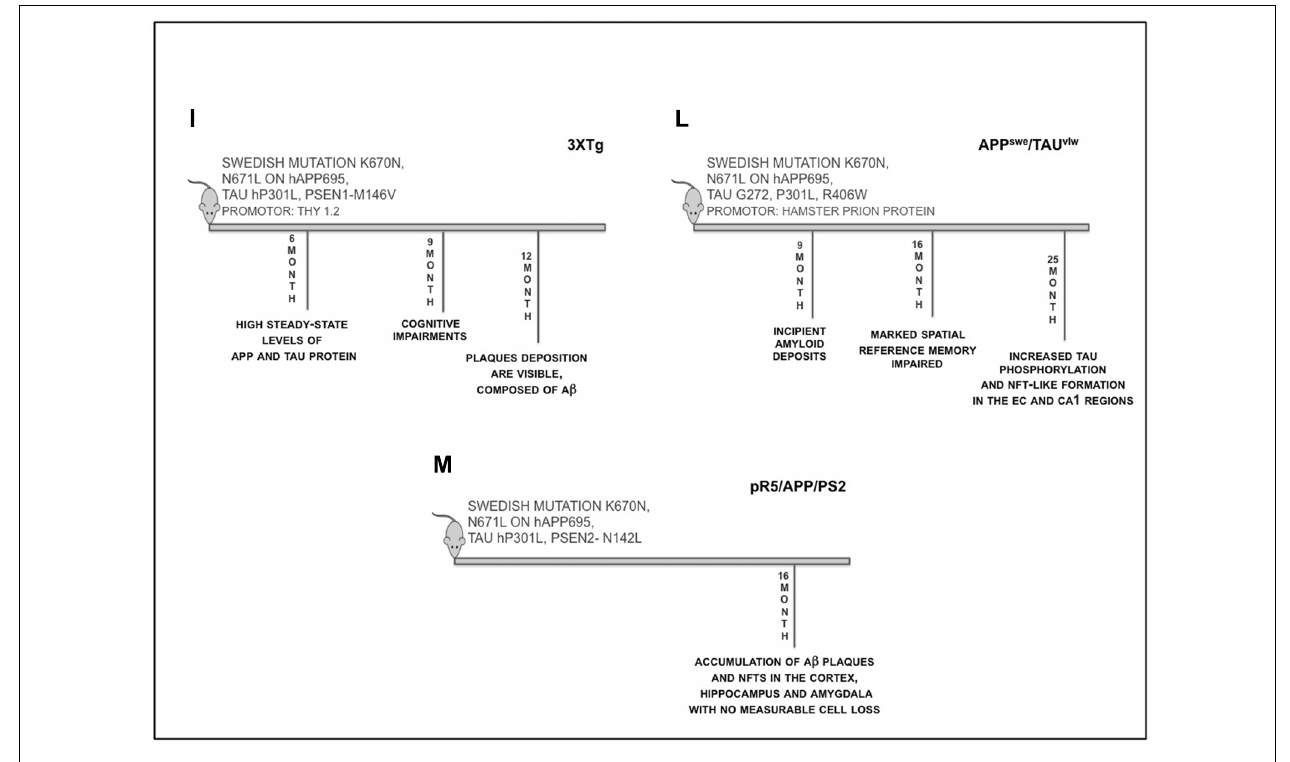
mutation, underThy-1 promoter; (H) APP swe /PSEN1dE9 mice express human APP with Swedish mutation (APPK670/671L) and PSEN1 with exon 9 deletion, under mouse PrP promoter; (I) 3xTg mice: in this model human APP695 cDNA harbouring the Swedish mutation (KM670/671NL) was subcloned into exon 3 of theThy1.2 expression cassette. Human four-repeat tau without amino terminal inserts (4R0N) harbouring the hP301L mutation was also subcloned intoThy1.2 expression cassette.The two were comicroinjected into the pronuclei of single-cell embryos harvested from homozygous PSEN1-M146V knockin mice; (L) APP swe /TAU vlw mice areobtained by crossingTg2576 mice andTAU vlw mouse lines expressing human 4-repeat tau containing a triple mutation (G272V, P301L and R406W) and both gene are under control of hamster PrP promoter; (M) pR5/APP/PSEN2 triple transgenic : APP swe PSEN2 N141I double transgenic mice were crossed with P301L tau transgenic pR5